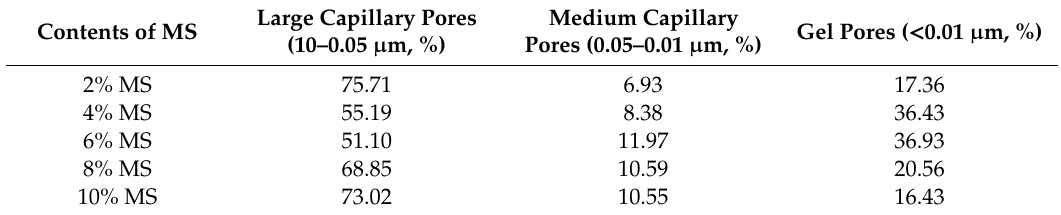
Table 2. Analysis of pore